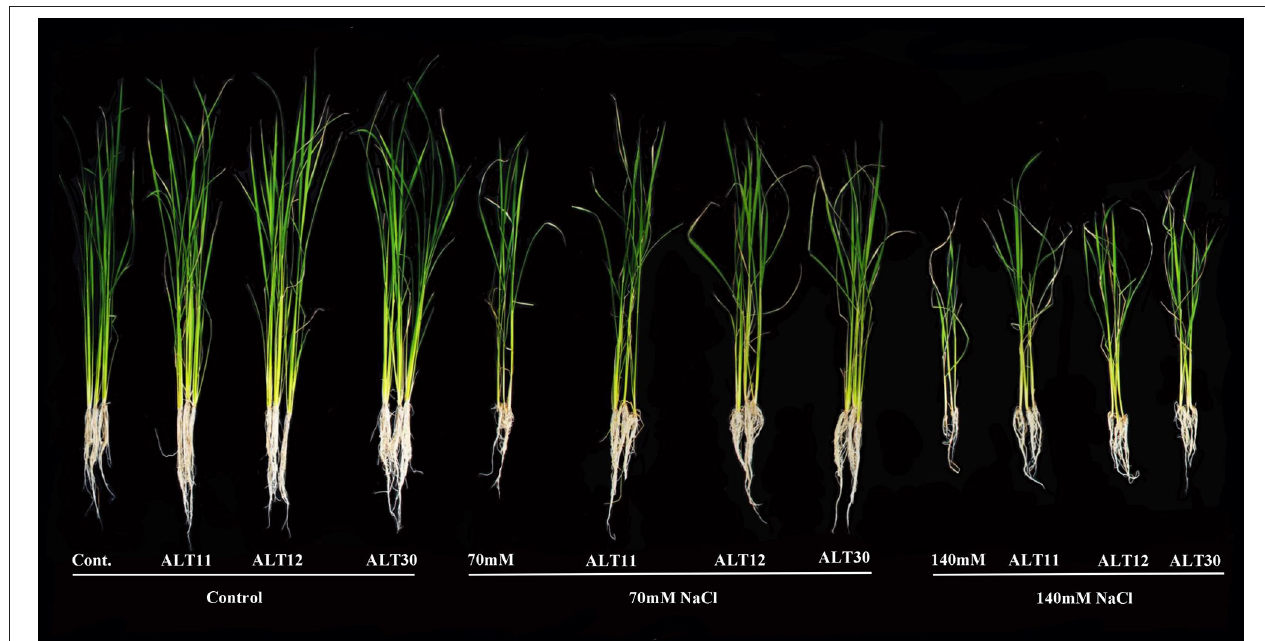
FIGURE 2 | Effects of selected bacterial isolates, ALT11, ALT12, and ALT30, on the growth of rice plants (9 weeks old) under standard salinity and 70 and 140mM NaCl stress.